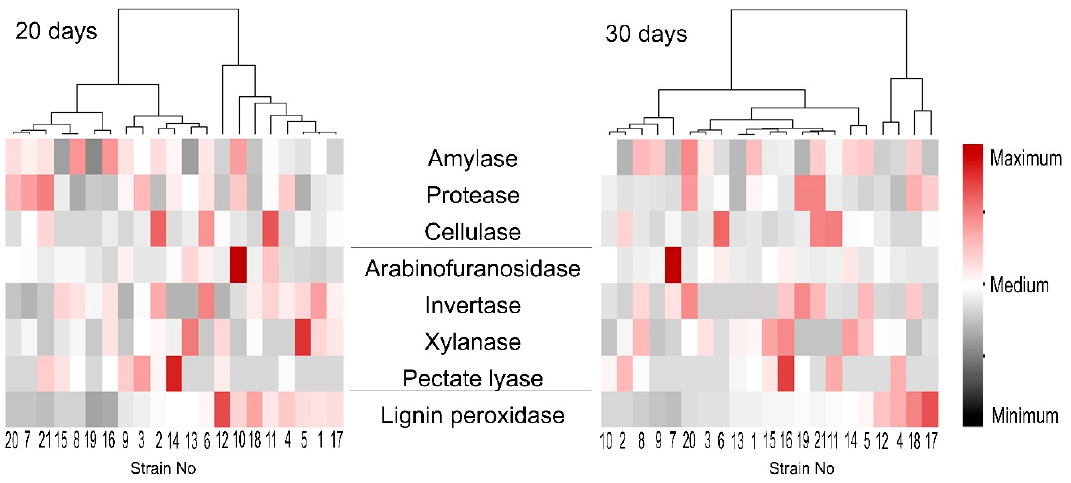
Figure 11. Heat map showing the relative patterns of extracellular enzymatic activities of different Microdochium nivale strains. The colors correspond to the level of activity (red (maximum), white (medium), and gray (minimum)) relative to the activity levels of all of the analyzed strains. The values (colors) are normalized in relation to a given activity of different strains but not in relation to different enzymatic activities. The heat map was made using R (version 3.6).